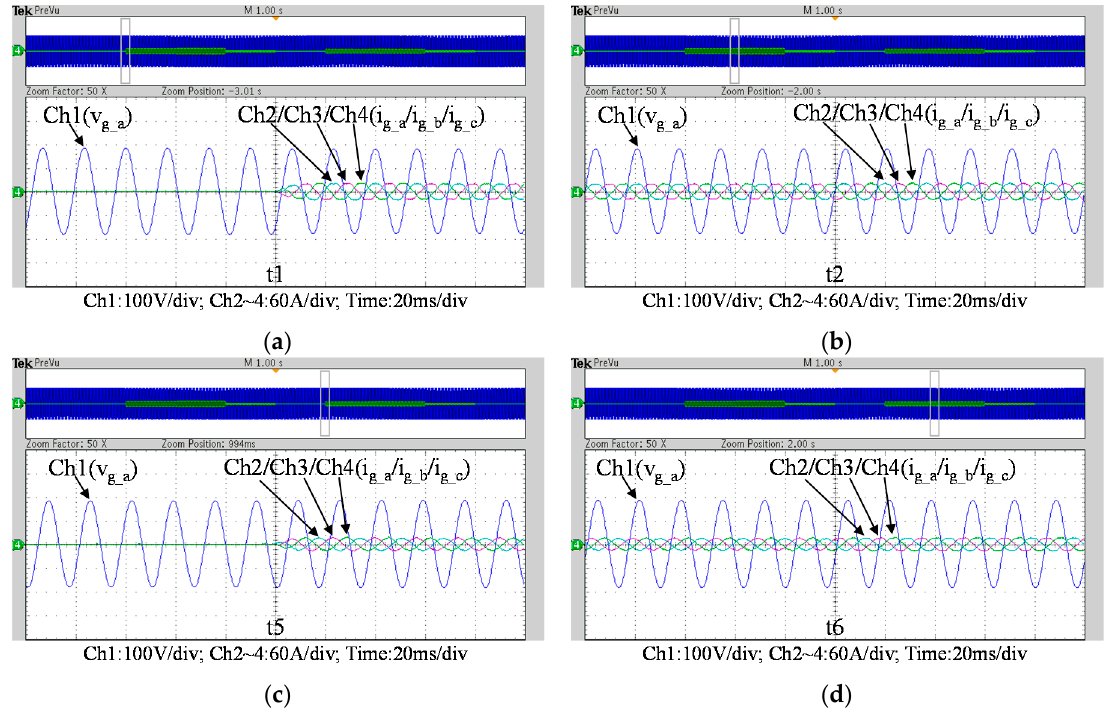
Figure 37. Detailed view of Figure 35b: ( a ) near t1; ( b ) near t2; ( c ) near t5; ( d ) near t6.